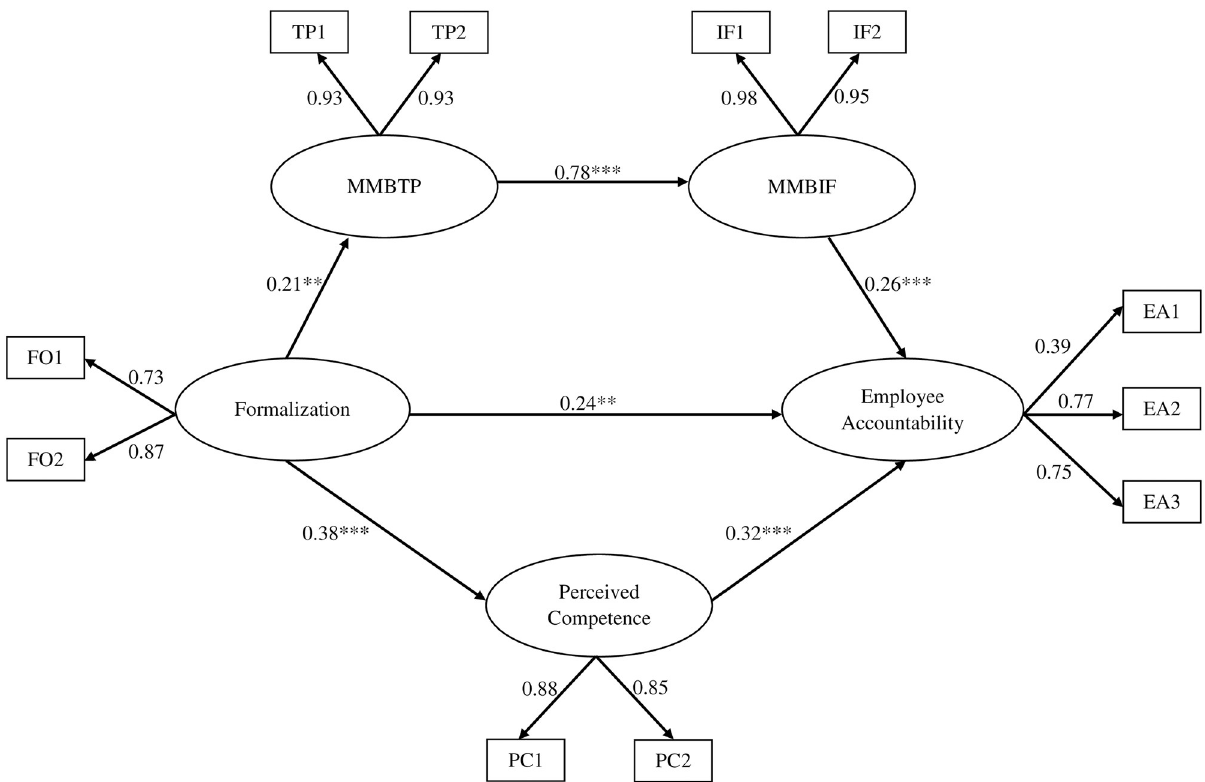
Fig 2. The mediating effect of managerial monitoring behavior and perceived competence on the relationship between formalization and employee accountability. MMBTP = Managerial monitoring behavior for task performance; MMBIF = Managerial monitoring behavior for interpersonal facilitation; TP1 = Managerial monitoring behavior for task performance 1; TP2 = Managerial monitoring behavior for task performance 2; IF1 = Managerial monitoring behavior for interpersonal facilitation 1; IF2 = Managerial monitoring behavior for interpersonal facilitation 2; FO1 = Formalization 1; FO2 = Formalization 2; PC1 = Perceived competence 1; PC2 = Perceived competence 2; EA1 = Employee accountability 1; EA2 = Employee accountability 2; EA3 = Employee accountability